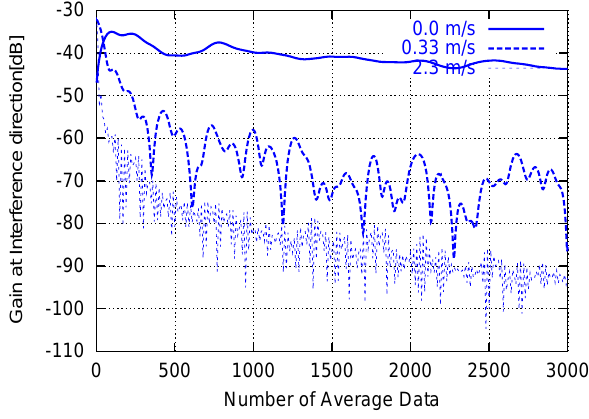
Fig. 10. Same as Fig. 9, but for the interferer with spectral width of 0.33m/s.